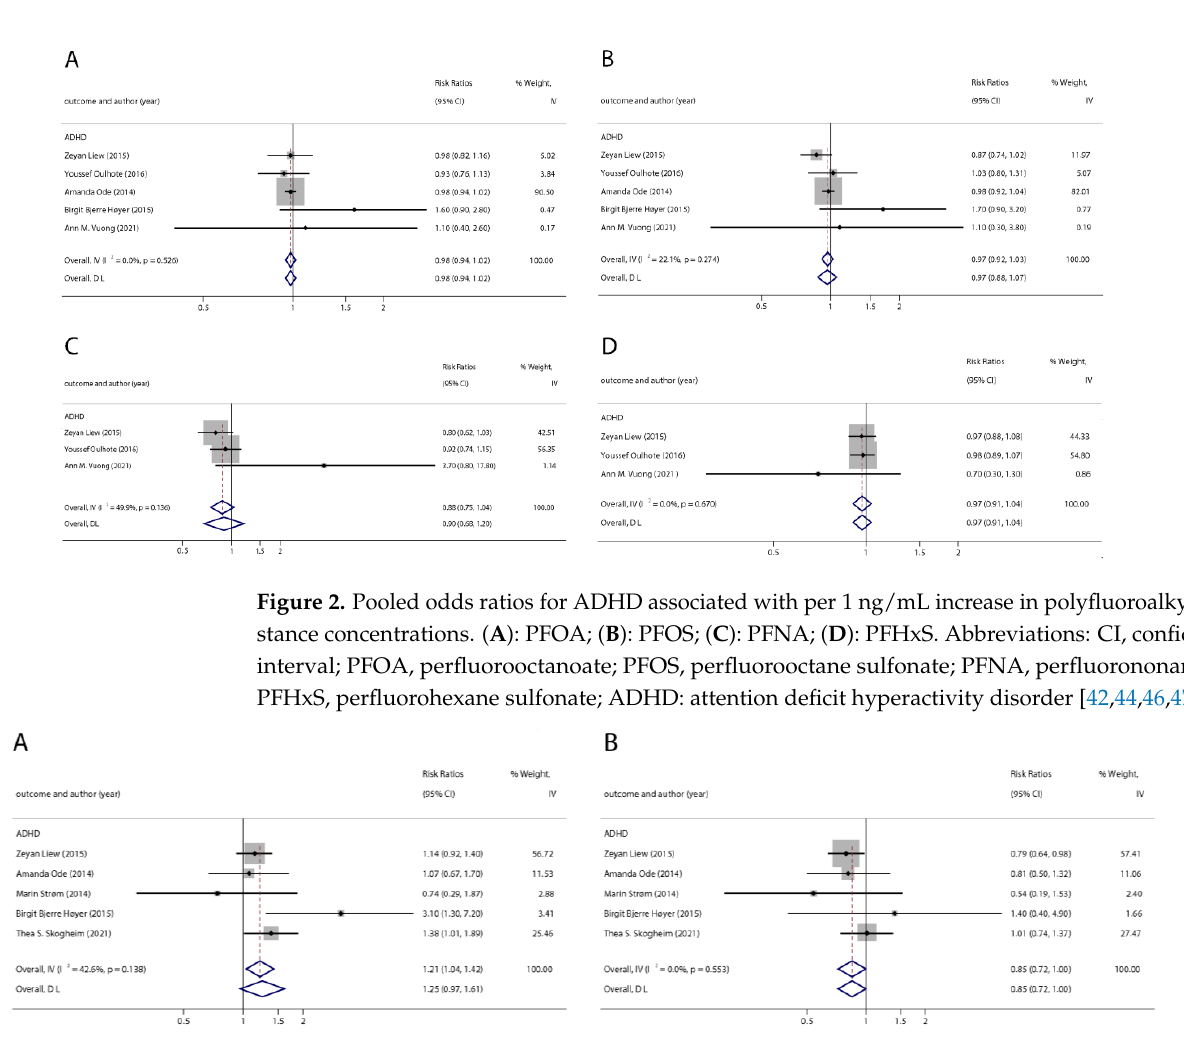
Figure 3. Pooled odds ratios for ADHD associated with polyfluoroalkyl substances concentrations: comparison of the highest category with the lowest category. ( A ): PFOA; ( B ): PFOS. Abbreviations: CI, confidence interval; OR, odds ratio; PFOA, perfluorooctanoate; PFOS, perfluorooctane sulfonate; ADHD: attention deficit hyperactivity disorder [42,43,47,48,50].